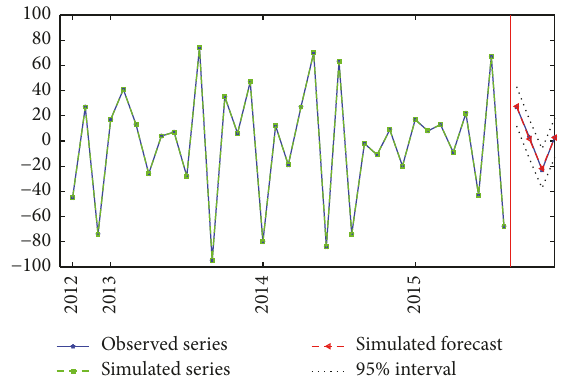
Figure 8: The actual, fitted, and forecasted series by hybrid model for series of injuries.